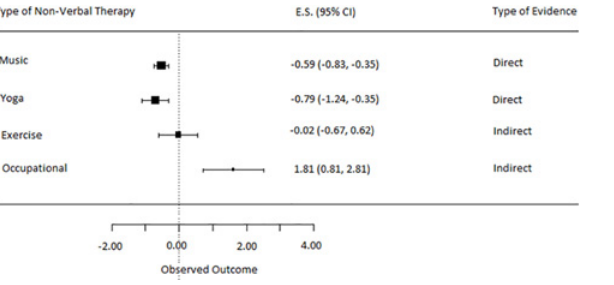
Fig 6. Network comparisons on depressive symptoms of all non-verbal therapies versus treatment as usual.